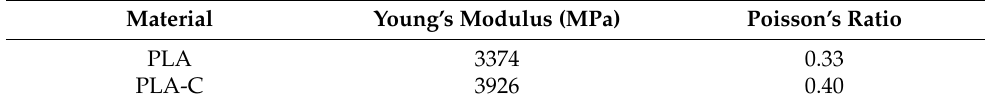
Figure 5. FEA model with ( a ) generated fixed supports, ( b ) loading condition for better replication of experimental testing, and ( c ) mesh geometry. Table 2. Material properties obtained from tensile testing of ASTM samples.